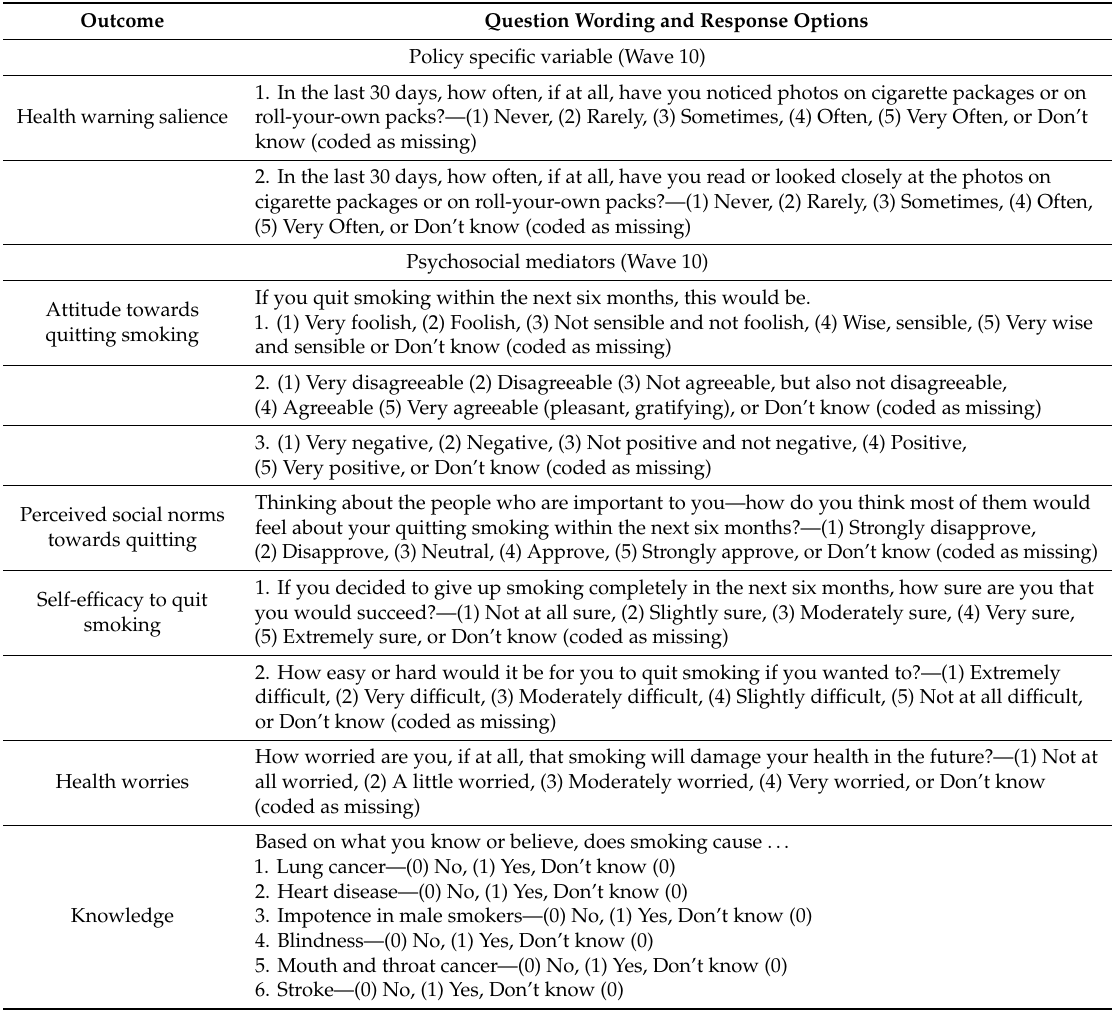
Table 1. Outcomes included in the